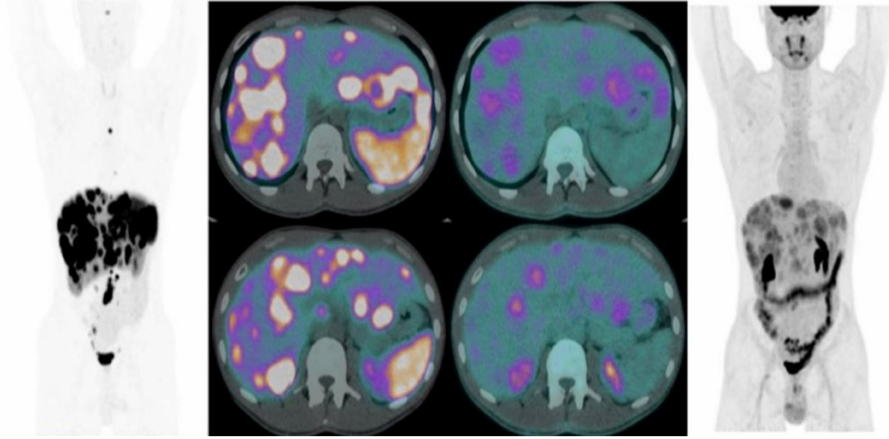
Figure 3. Combined imaging 68 Ga-DOTA-SSAs-PET/CT and 18 FDG-PET/CT in G2 small bowel NET showing heterogeneity of the